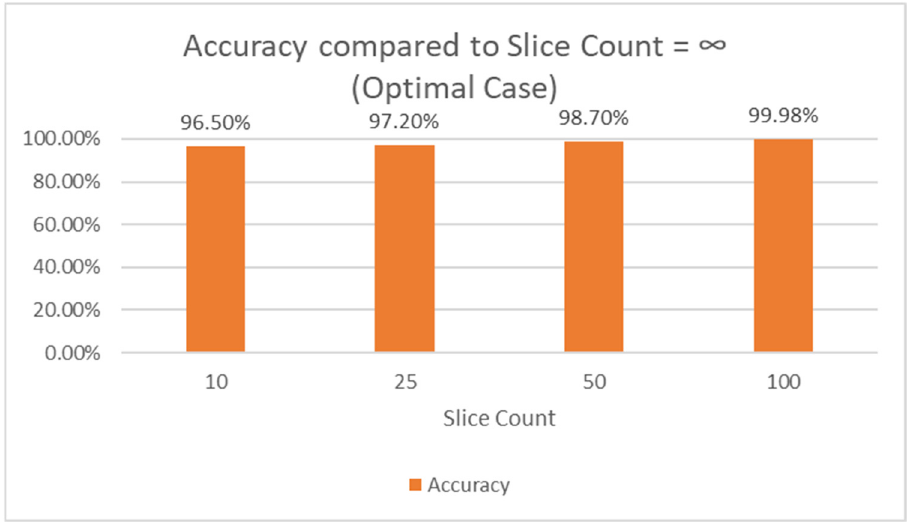
Figure 9. Accuracy compared to result in the absence of slice counting.